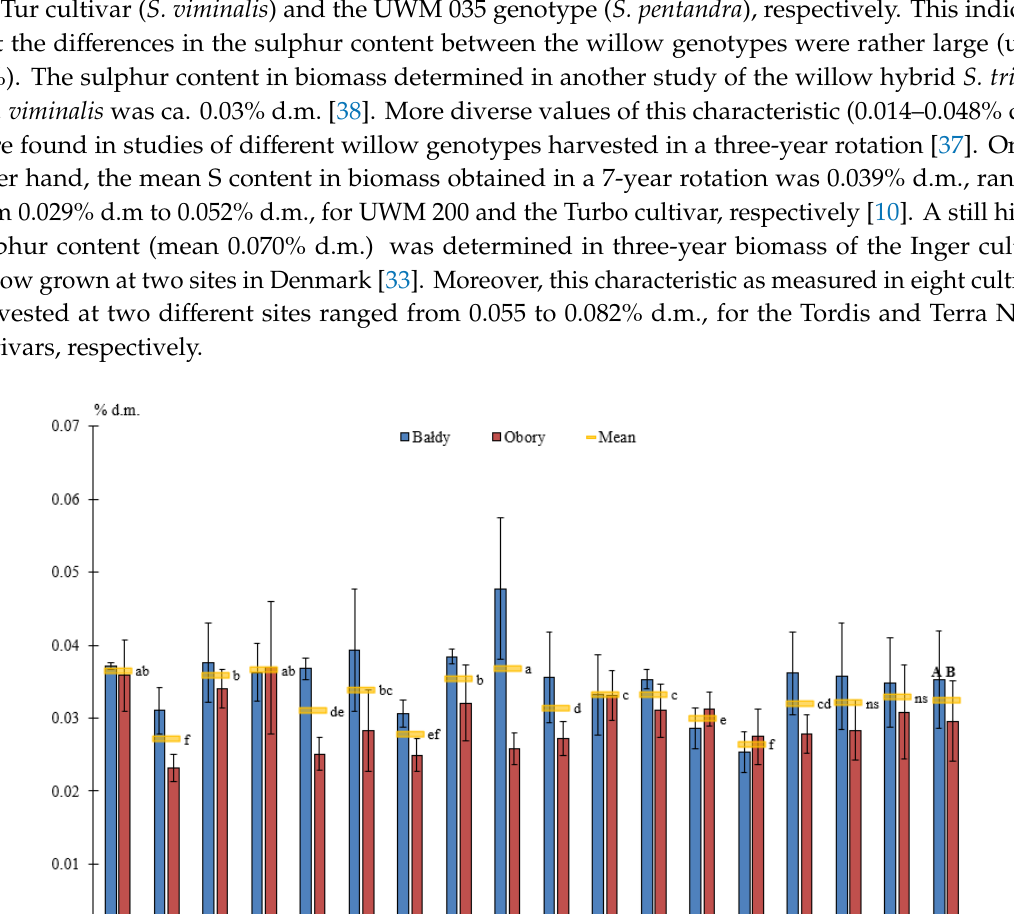
Figure 10. Nitrogen content in the biomass of 15 willow genotypes obtained at two locations in two consecutive three-year harvest rotations; (legend: see Figure 1).